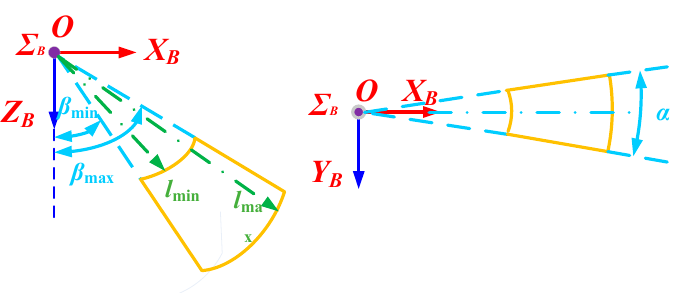
Figure 6. Projection of the operational space Ω in the X B -O-Z B (left) and X B -O-Y B (right) planes.